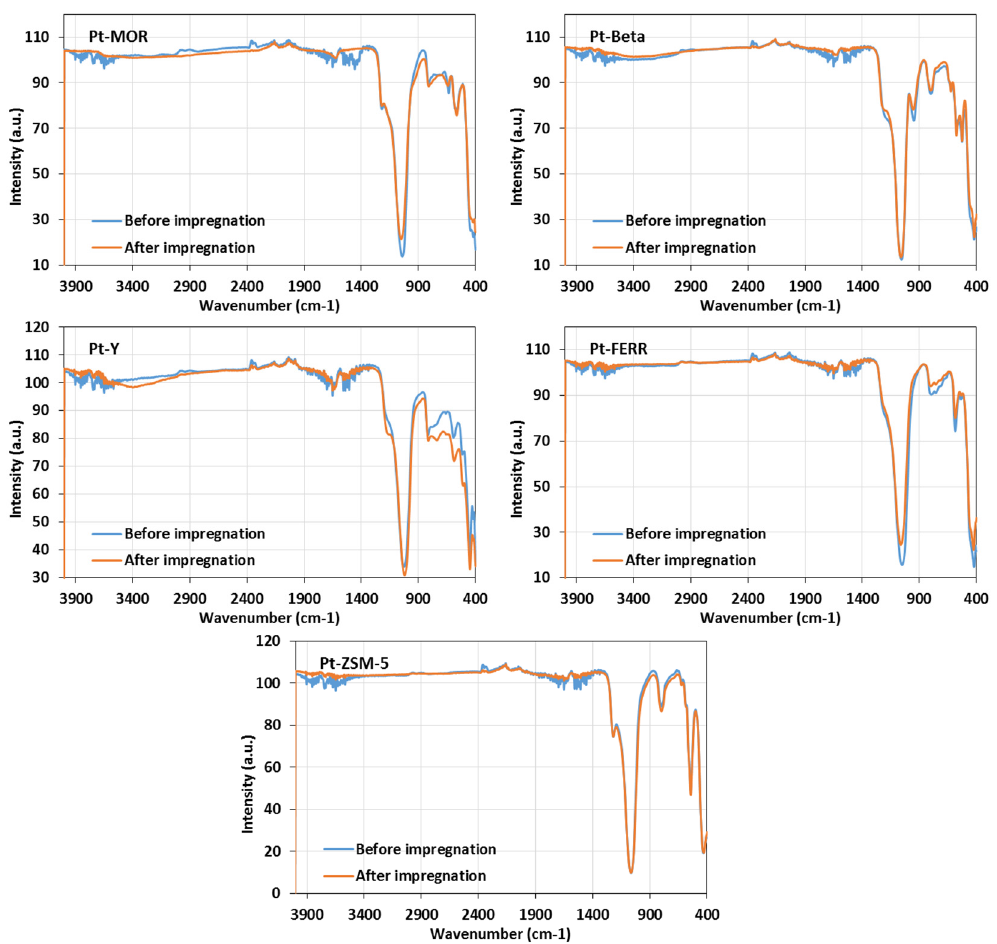
Figure 3. The FTIR spectra of the prepared Pt-incorporated zeolite materials (Y, Beta, MOR, FERR, and ZSM-5) before and after Pt incorporation.